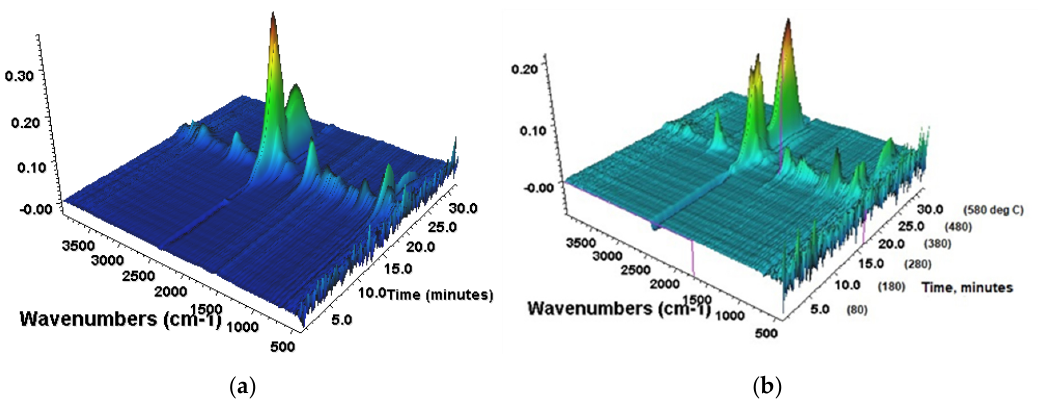
Figure 5. Exemplar 3D plots of TGA-FTIR data for ( a ) pure PA66 and ( b ) ZnW-BrPS under air. The CH x (2933 cm − 1 ), CO 2 (2357 cm − 1 ) and NH 3 (968 cm − 1 ) peak intensities as a function of